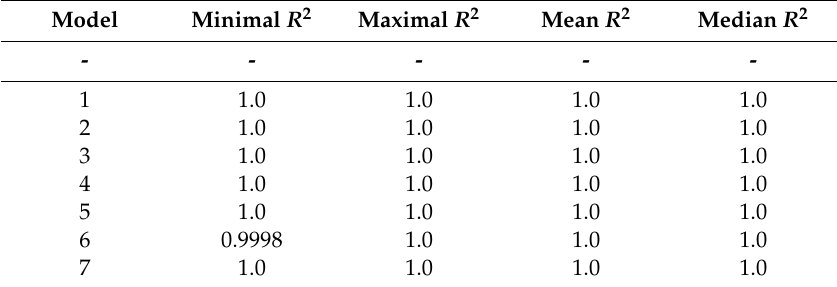
Table 3. Overview over the R 2 -statistics between the pressure heads computed with PCSiWaPro Original and PCSiWaPro